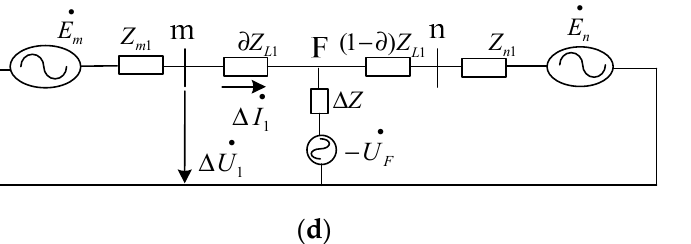
Figure 3. Circuit diagrams of positive sequence fault components. Where ( a ) is the positive sequence network with faults in line L of the double-terminal power supply linear system in Figure 2; ( b ) is the equivalent diagram of two additional power sources connected in series in the additional impedance branch; ( c ) is the pre-fault operation diagram of graph ( b ) decomposed by superposition theorem; ( d ) is the post-fault positive sequence fault component additional state diagram of graph ( b ) decomposed by the superposition theorem. Table 1. Additional impedance ∆ Z under different fault types.